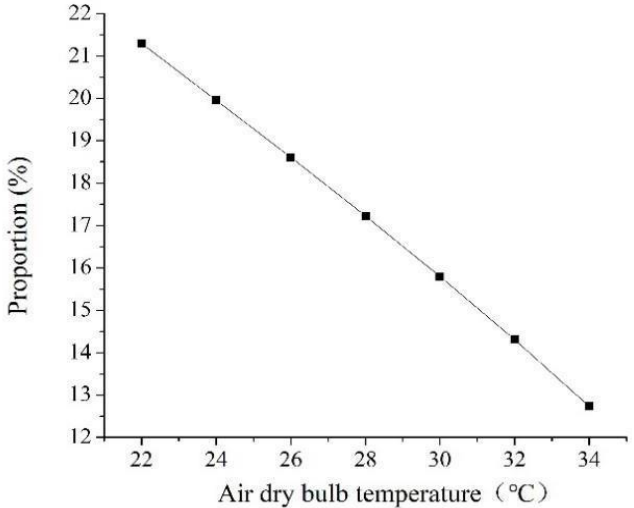
Figure 14. Relationship between the proportion of contact heat dissipation to total heat dissipation and air-dry bulb temperature.